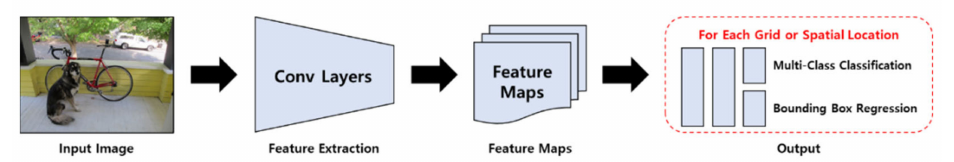
Figure 1. One-stage detector image processing process.